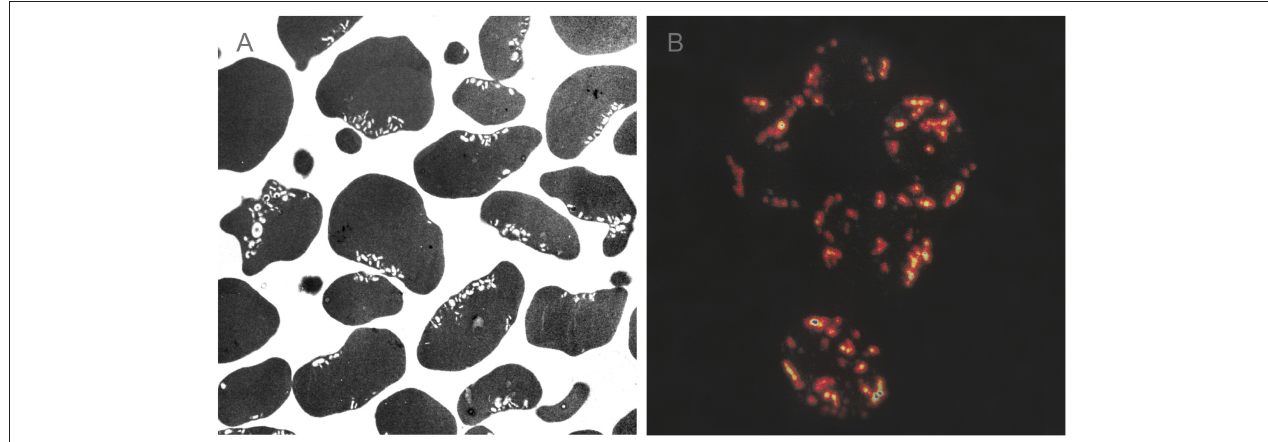
FIGURE 1 | Transmission electron micrograph (A) and confocal laser scanning microscopy of invaginated stomatocytic RBC incubated with amphiphilic molecules chlorpromazine (B) . Chlorpromazine molecules induce the formation of a large number of small membrane buds/endovesicles. Adapted from Hägerstrand et al. [17] and Bobrowska-Hägerstrand et al. [63].